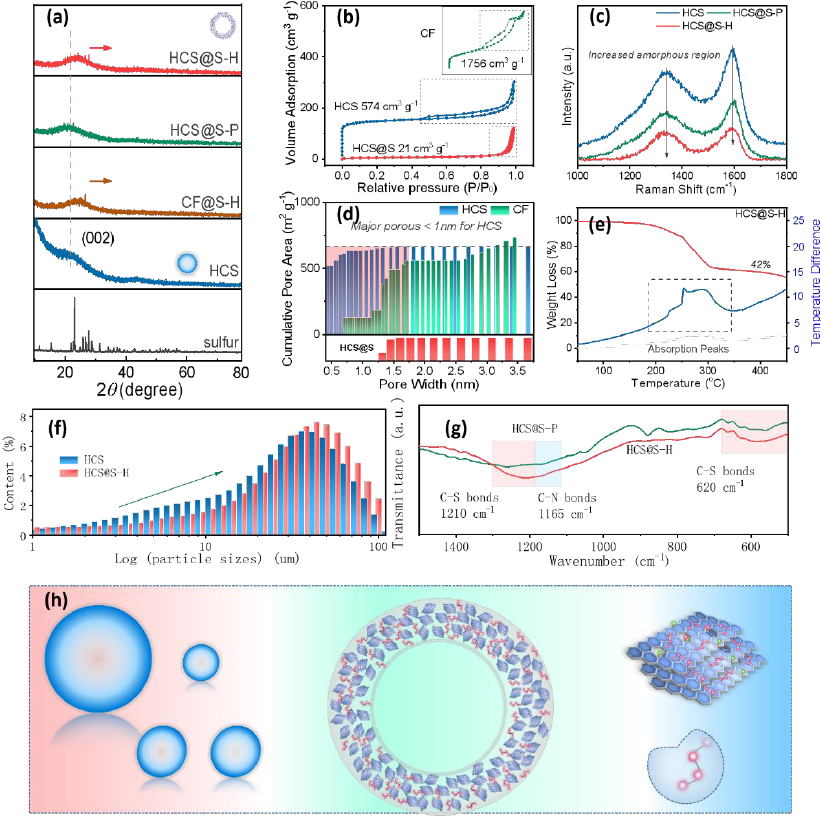
Figure 1. The physical-chemical properties of the as-resulted samples: XRD ( a ), specific surface area ( b ), Raman ( c ), porous distribution ( d ), TG curves ( e ), particles size distribution ( f ), FTIR ( g ) and the formation mechanism ( h ).